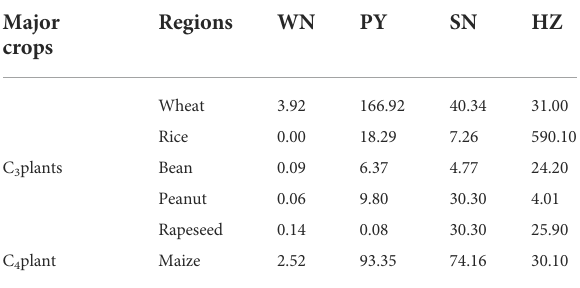
TABLE 2 The annual yield of major crops in four regions (Unit: ten thousand tons). Major crops